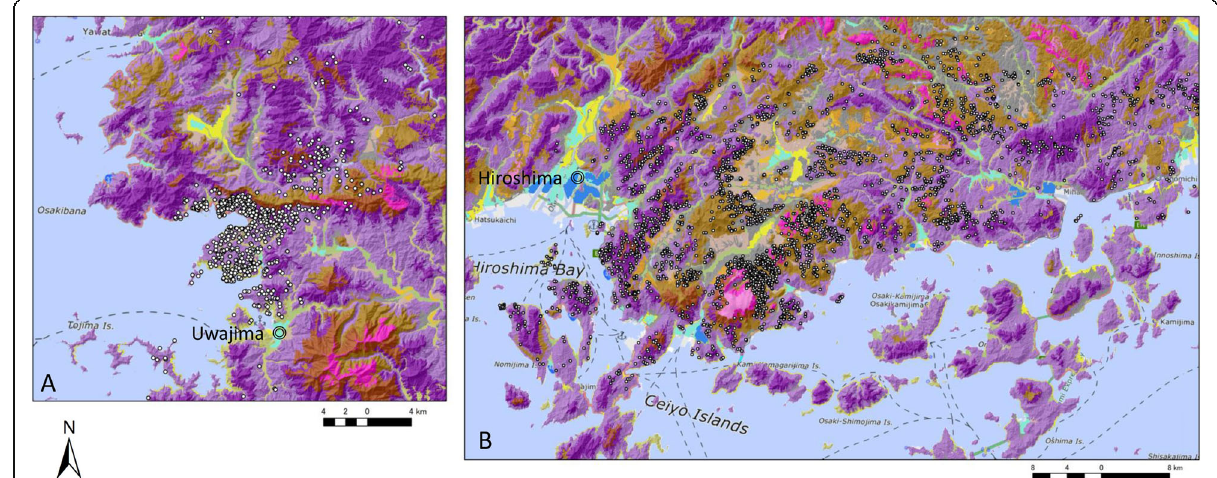
Fig. 16 Image overlays of shallow landslides caused by 2018 July heavy rainfalls. Legend of the classification is the same as in Fig. 14. Location maps are included in Fig. 14. The center points of shallow landslides (white circles) were interpolated by GSI (2018) using digital aerial photographs. a Around Uwajima, Ehime Prefecture. b Around Hiroshima, Hiroshima Prefecture